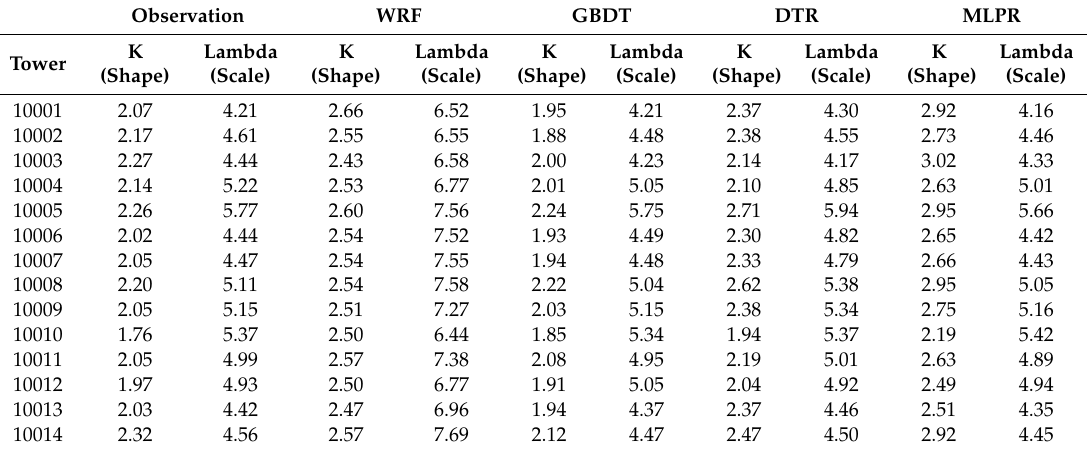
Figure 13. IA results of 14 towers in different month and different hour, ( a ) the WRF results, ( b ) the GBDT results, and ( c ) the improved value of GBDT relative to WRF result. Table 12. Shape and scale parameters of 10 m wind speed Weibull